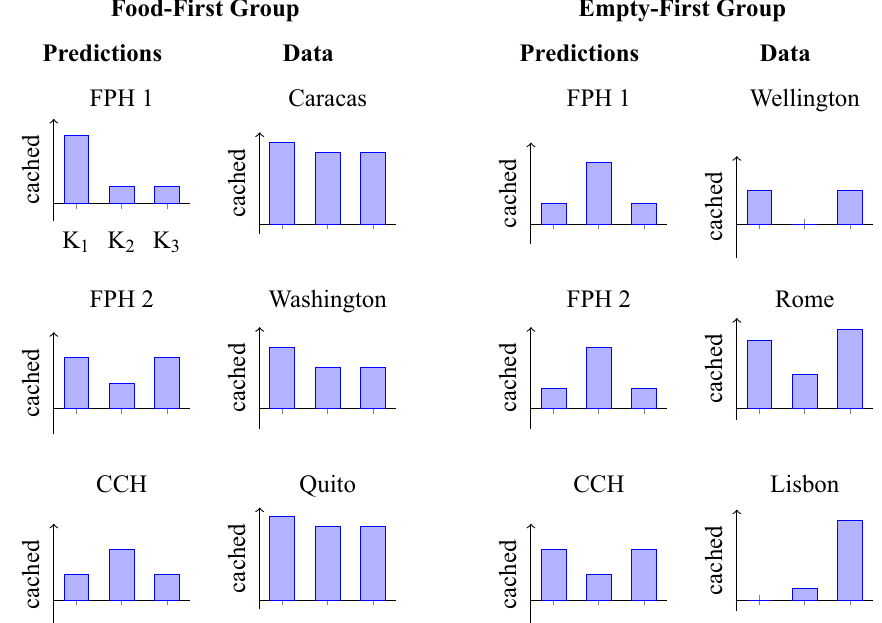
Figure 6. Individual caching patterns allow no conclusion. K1 = compartment available on trials 1, 4, 7; K2 = compartment available on trials 2, 5, 8; K3 = compartment available on trials 3, 6, 9. A bird in the Food- First group should expect not to receive powdered food on test day 10. If it caches according to Prediction 1 of the Future Planning Hypothesis (FPH 1), it will provision only for the next day, when it expects to be in compartment K1 with no food available; thus it would cache most in K1. If a bird caches according to Prediction 2 of the Future Planning Hypothesis (FPH 2), thereby taking into account the next three days, then it will distribute the caches across compartments K1 and K2. If the bird caches according to the Compensatory Caching Hypothesis (CCH), the bird should cache more in compartment K2, where it has only once encountered the powdered food. The predicted caching pattern for birds in the Empty-First group is reversed, because on day 10 they will have food available in compartment K1. The two variants of the Future Planning Hypothesis are indistinguishable for the Empty-First group (see text for details). The actual numbers in the predictions serve for illustration purposes only. The hypotheses allow only qualitative predictions, e.g. the